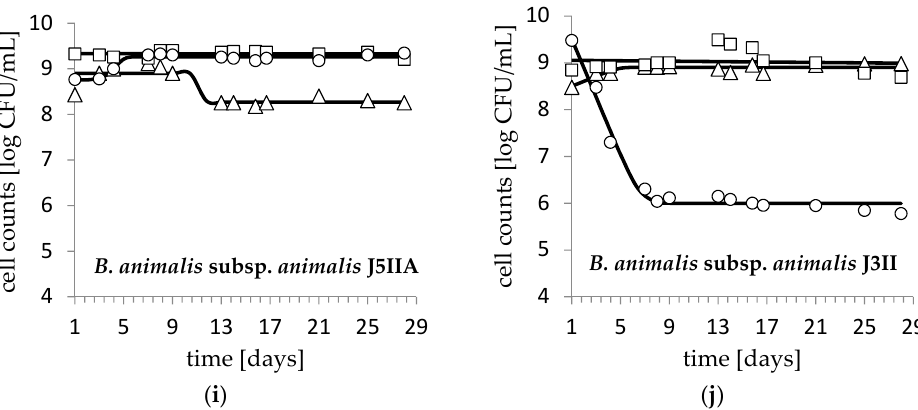
Figure 1. Survival of bifidobacteria in modified Wilkins–Chalgren (WCH) broth ( ∆ ), fermented reconstituted milk ( □ ), and fermented ultra-high-temperature (UHT) milk ( ○ ) at 6 °C within four weeks. lactis DSM 10140 ( a ) B. animalis subsp. animalis DSM 20104 ( b ) B. thermophilum DSM 20212 ( c ) B. animalis subsp. animalis 805 III2 ( d ) B. thermophilum 17 III2 ( e ) B. choerinum K1 / 1 ( f ) B. pseudolongum K4 /